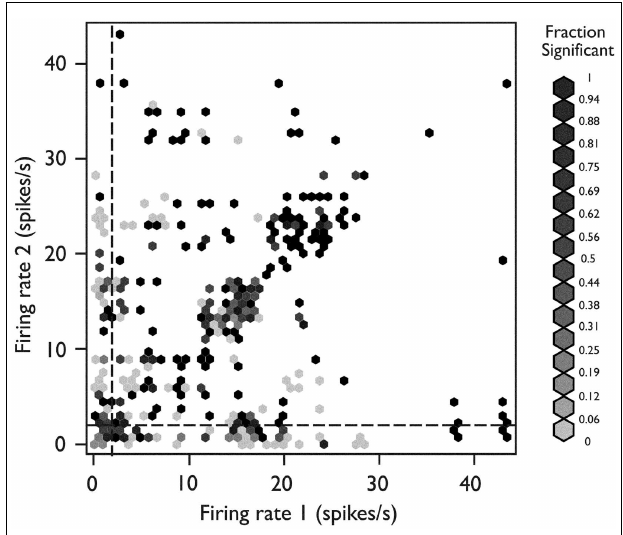
FIGURE 6 | Relationship between network behavior and mean firing rate . Each neuron pair is plotted according to the mean firing rate of neuron 1 ( x -axis) and neuron 2 ( y -axis).The relative strength for synchronous firing behavior for each pair is grayscale coded within the hexagon representing that pair (darker hexagon indicates a pair with more synchronous firing behavior within the recording epoch).The neuron pairs in which both neurons were members of the fast-firing class (mean firing rate > 2sp/s) were more likely to exhibit synchronous firing behavior ( p < 10 − 15 , Fisher’s exact test). Used with permission from Barrow Neurological Institute.